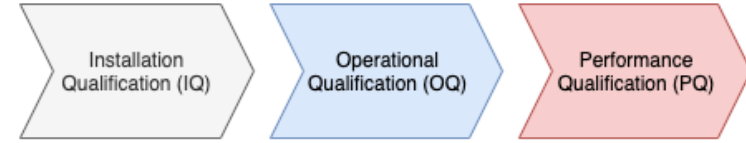
Fig. 5. TCS software validation phases; IQ,OQ and